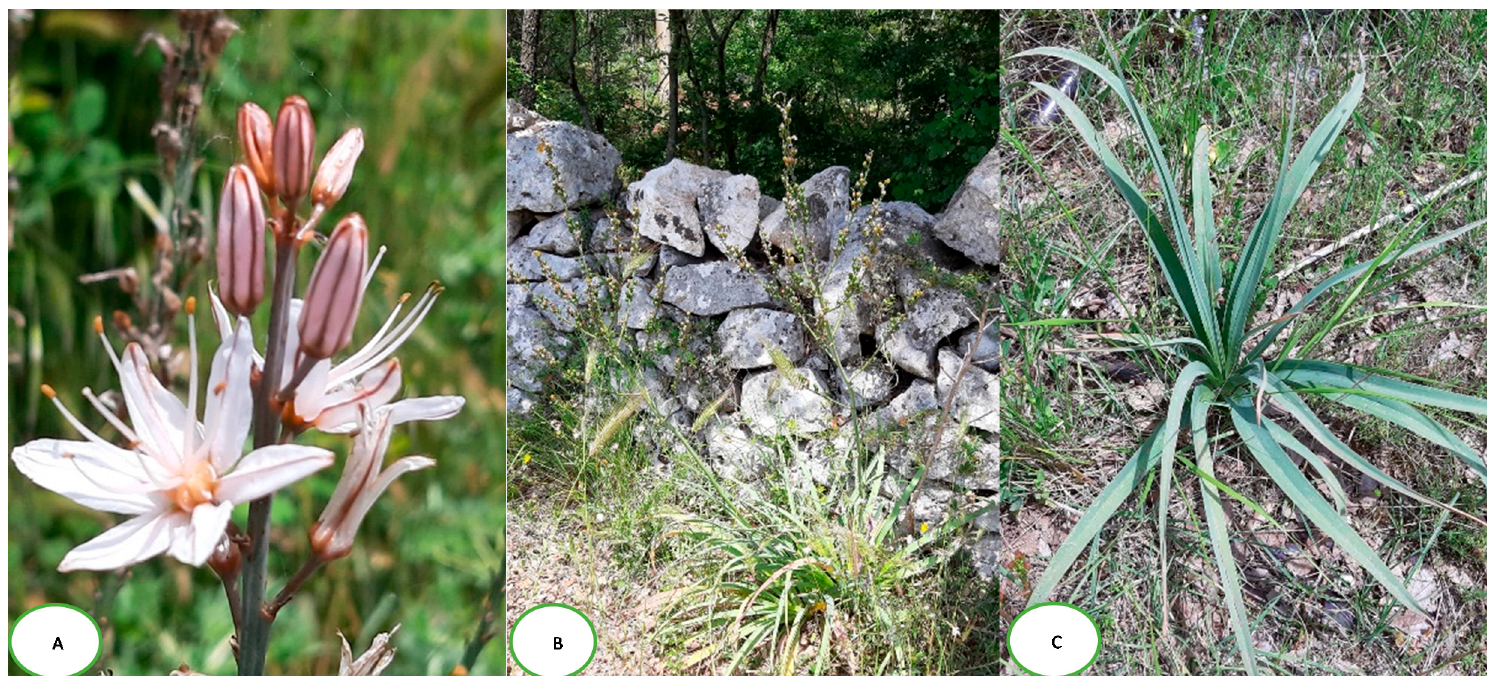
Figure 1. Asphodelus microcarpus : ( A ) Flower; ( B ) plant with fruits; ( C ) leaves; Photographs taken in the Pianelle woods, Martina Franca, Italy, May 2019.